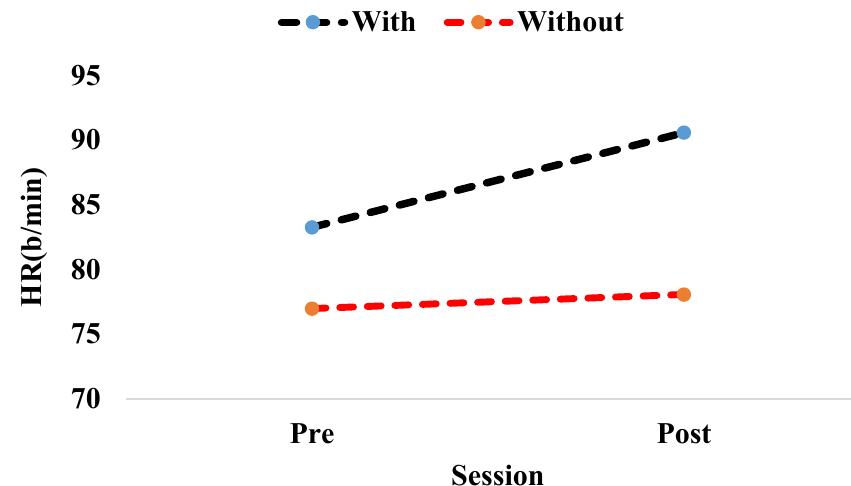
Figure 4. Interaction effects between the session and the assembly methods (with pedaling exercise and without pedaling exercise) on the HR.